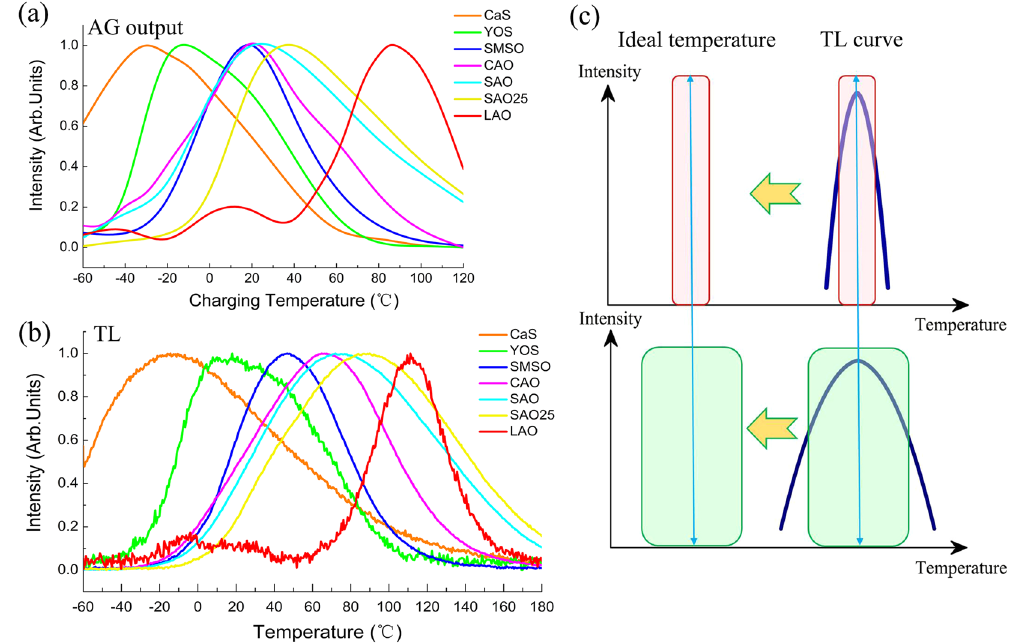
Figure 6. ( a ) Comparison of the normalized afterglow output of the different LPPs. ( b ) Comparison of the normalized TL glow curves of the different LPPs. ( c ) Schematic view of the relation of the optimum temperature range and TL glow curve.